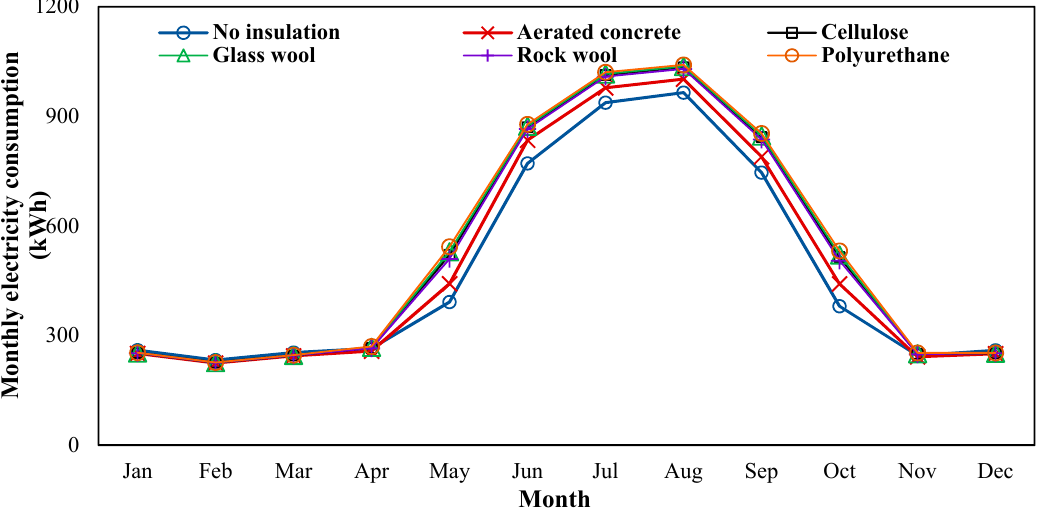
Figure 15. Monthly NG consumption for different insulation materials.